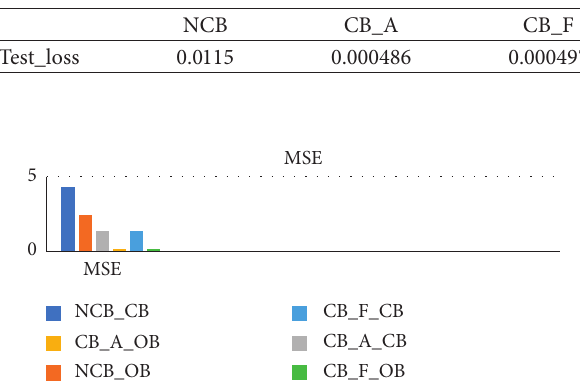
Figure 11: Comparison of test losses. Table 3: Comparison of test losses.